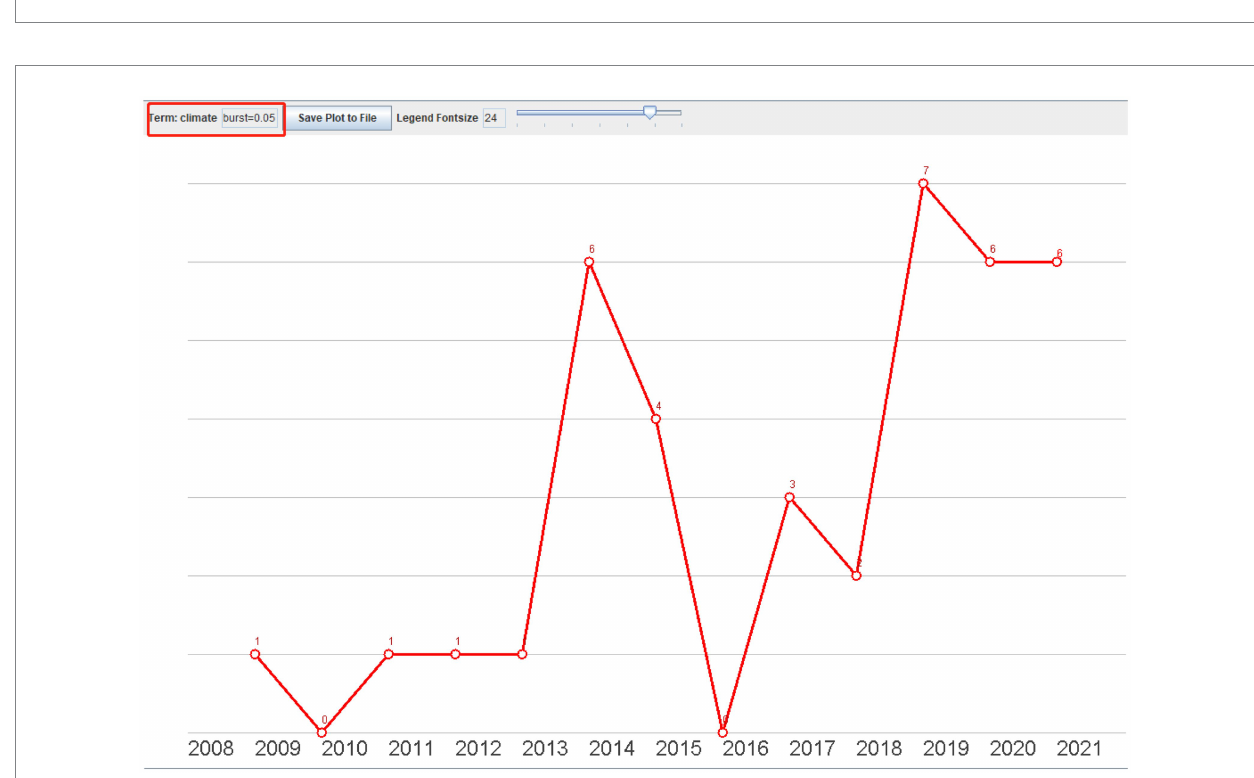
FIGURE 6 Keyword timeline map of climate migration (WOS 2008–2021).